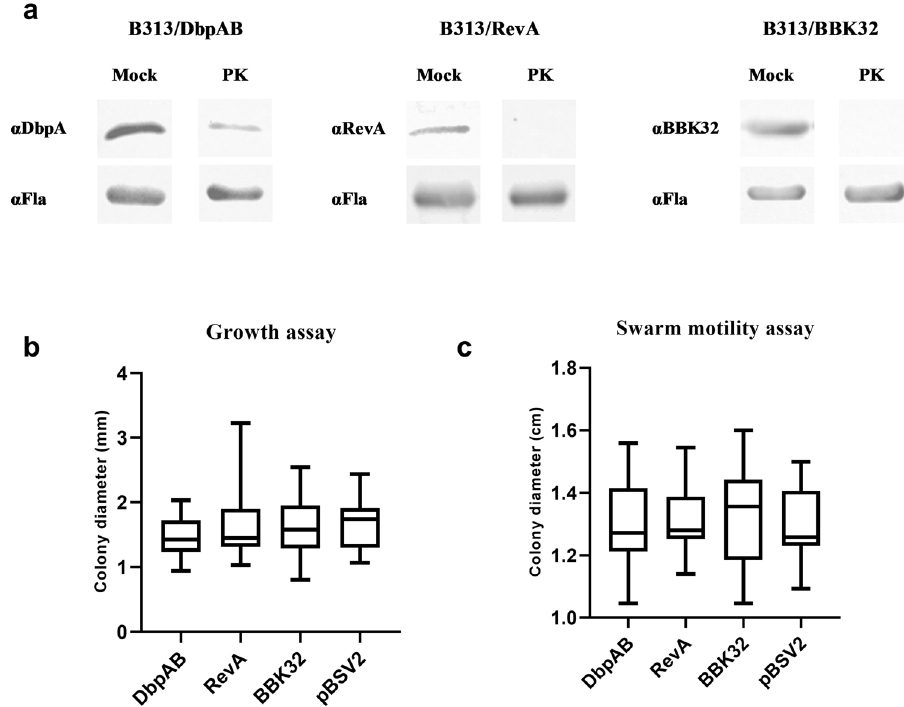
Fig. 1 Expression of adhesins does not enhance undirected motility in standard in vitro conditions. a To determine if DbpAB, BBK32, and RevA proteins are present in borrelial lysates and are surface exposed, a proteinase K (PK) assay was employed. PK-treated and -untreated lysates of recombinant B. burgdorferi B313 strains (B313/DbpAB, B313/RevA, B313/BBK32) expressing DbpA and DbpB, RevA, and BBK32 were separated by SDS-PAGE and immunoblotted with the indicated antibodies ( α , anti). Bands corresponding to speci fi c proteins are absent or faint from PK treated samples. The intensity of subsurface fl agellar protein bands are identical between mock and PK treated cells, indicating surface localization of the adhesins. b , c The effect of DbpAB, RevA, and BBK32 on the undirected movement of spirochetes was studied using growth and swarm motility assays. Empty shuttle vector pBSV2 was used as the control. Results are expressed as arithmetic mean and were compared by one-way ANOVA. Error bars, standard deviation. In the growth assay, 30 colony diameters were measured for each mutant strain. In the swarm motility assay, 12 diameters for each strain were measured. Differences were not statistically signi fi cant ( P >